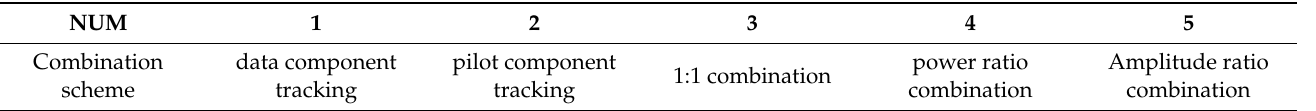
Table 3. L1C/B1C signal combination schemes.